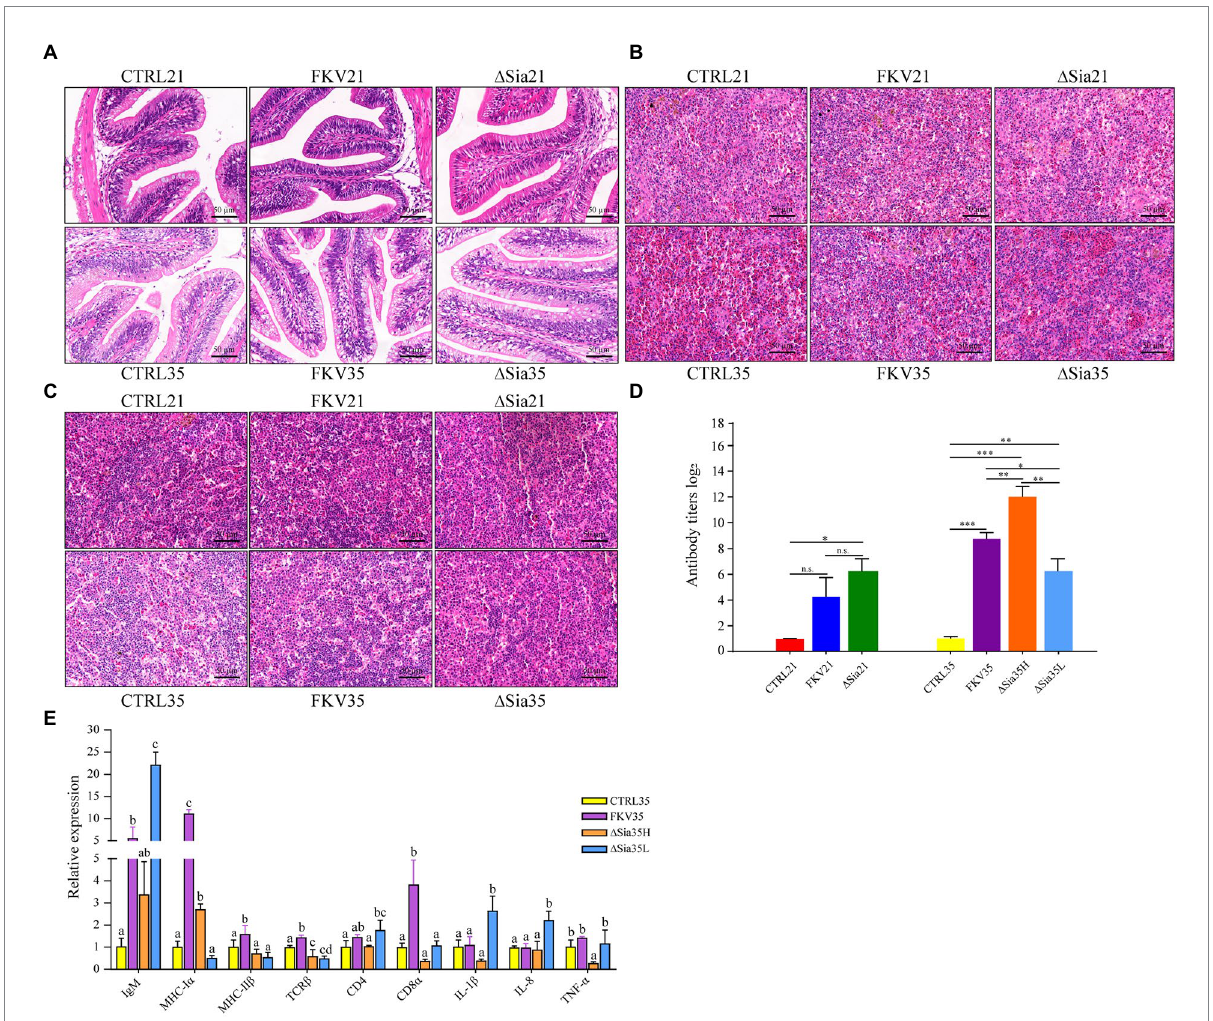
FIGURE 6 Effects of FKV and LAV vaccination on histology, serum antibody levels, and mucosal immunity-related gene expression in tilapia. (A) Representative images of hindgut tissue sections for each group (HE 400×); (B) representative images of spleen tissue sections for each group (HE 400×); (C) representative images of head kidney tissue sections for each group (HE 400×). (D) Serum antibody agglutination titers. Data are presented as mean ± SD ( n = 4), and the difference between groups was determined through one-way ANOVA followed by Dunnett’s T3 (3) post hoc tests by using SPSS 18.0 (SPSS, Chicago, United States). * p < 0.05, ** p < 0.01, and *** p < 0.001. n.s., no significance. (E) Relative transcriptional levels of immune-related genes in the hindgut mucosa of tilapia at 35 dpiv. The histogram shows the means ± SD of three replicates. Differences in immune-related gene expression between groups were determined by one-way ANOVA followed by LSD post hoc tests by using SPSS 18.0. Different letters indicate significant differences between groups at 95% confidence intervals. CTRL21, control group at 21 dpiv; FKV21, FKV group at 21 dpiv; ∆ Sia21, LAV ∆ Sia group at 21 dpiv. CTRL35, control group at 35 dpiv; FKV35, FKV vaccine group at 35 dpiv (14 days after the second immunization); ∆ Sia35H, LAV ∆ Sia group with a high serum antibody response at 35 dpiv (14 days after the second immunization); ∆ Sia35L,